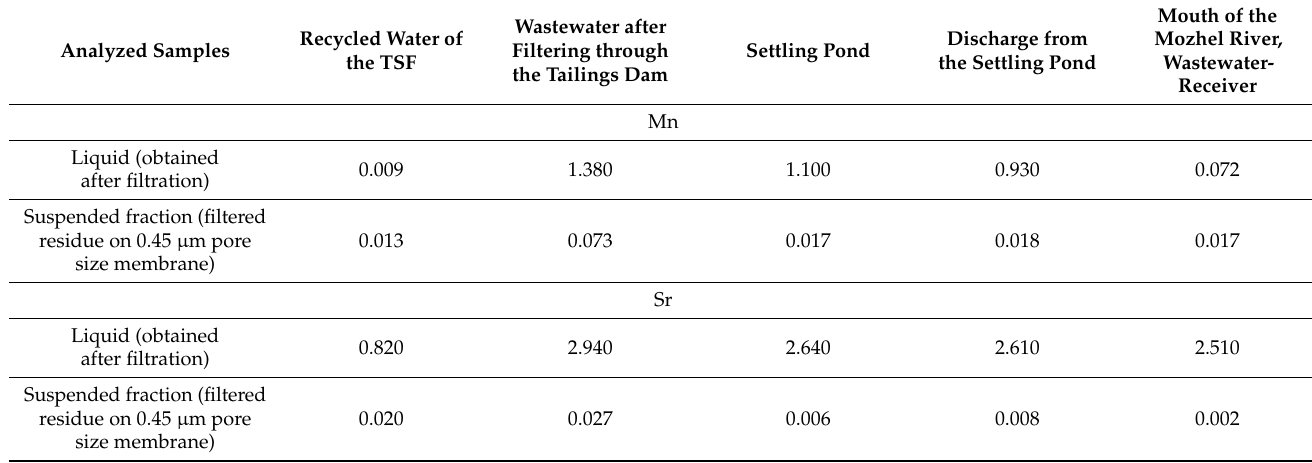
Table 4. Distribution of Mn and Sr between phases in the studied waters, mg/dm 3